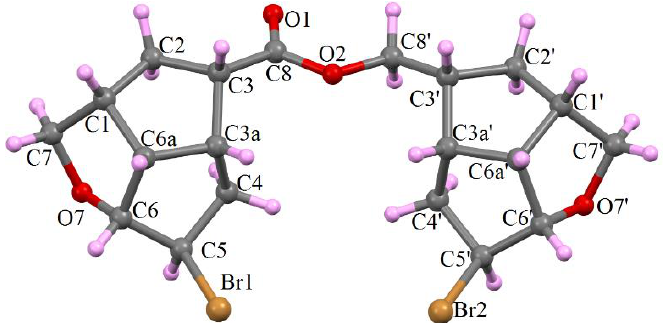
Figure 3. X-Ray molecular configuration of the asymmetric unit for secondary compound 6c .